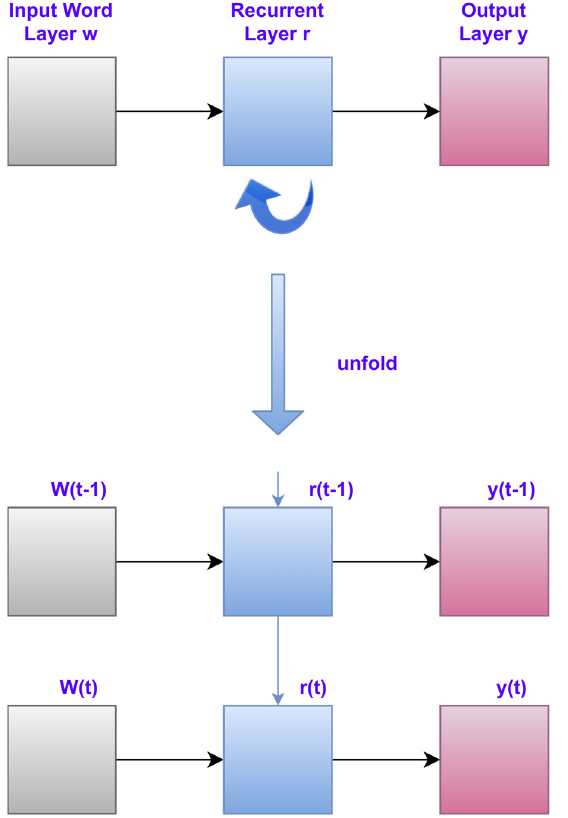
Figure 2. Simple RNN architecture.